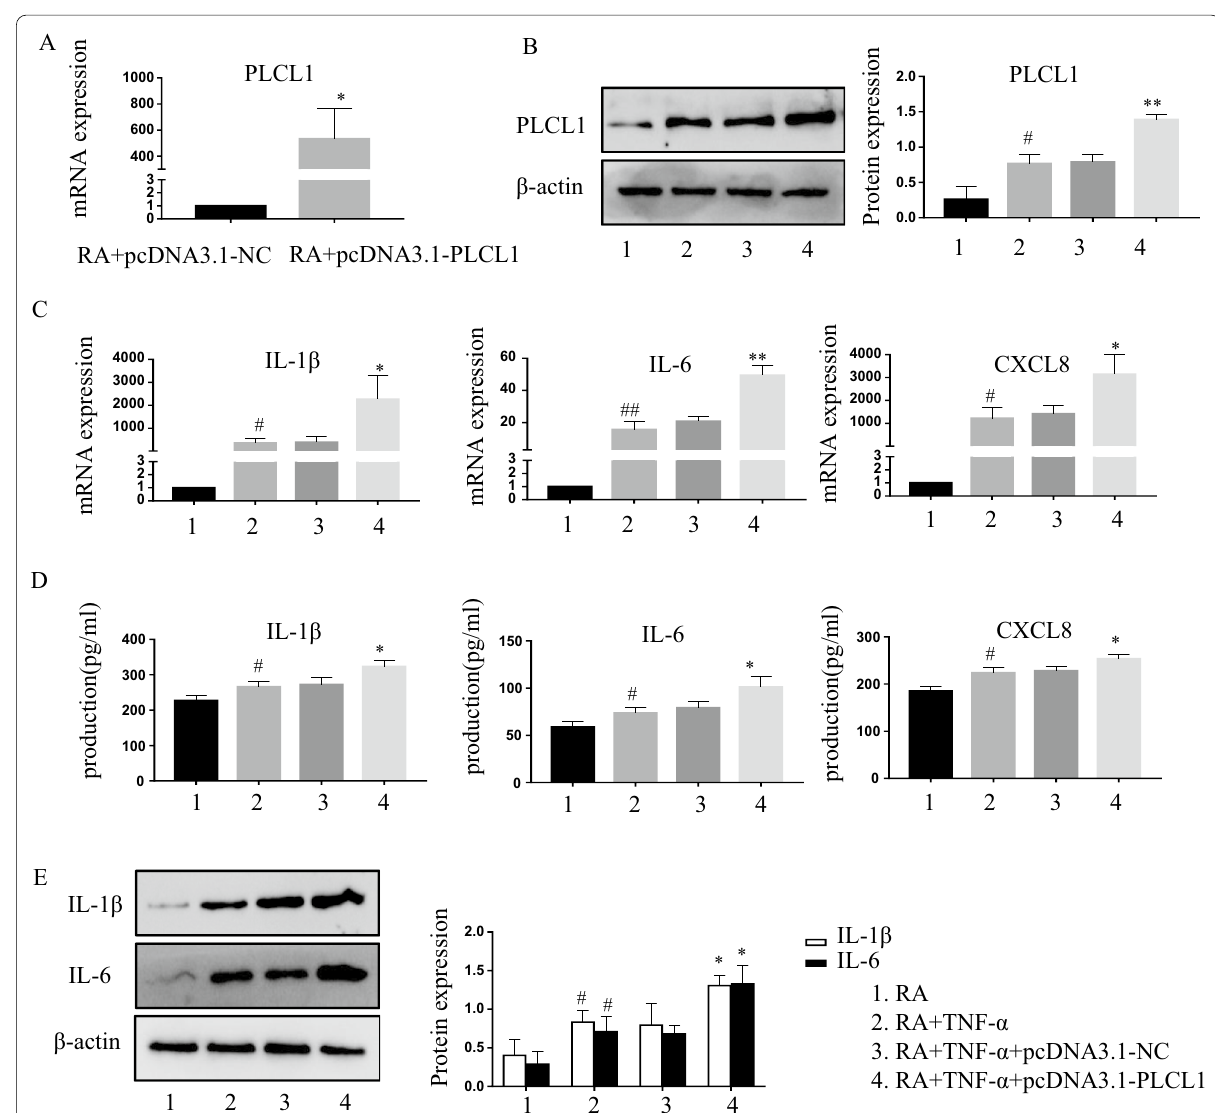
Fig. 4 Effect of PLCL1 overexpression promoted FLS expressing inflammatory cytokines. a The overexpression efficiency of PLCL1 were analyzed by RT‑QPCR in RA FLS. b The protein levels of PLCL1 were analyzed by WB in TNF‑α‑incubated in RA FLS after using PLCL1 overexpression plasmids. c The mRNA levels of IL‑6, CXCL8 and IL‑1β were analyzed by RT‑QPCR in TNF‑α‑incubated in RA FLS after using PLCL1 overexpression plasmids. d ELISA was used to detect the production of IL‑6, CXCL8 and IL‑1β in TNF‑α‑incubated RA FLS supernatants after using PLCL1 overexpression plasmids. e The protein levels of IL‑6 and IL‑1β were analyzed by WB in 10 ng/ml TNF‑α‑incubated in RA FLS after using PLCL1 overexpression plasmids. (Compared with the RA group # P < 0.05, ## P < 0.01; compared with the negative control group * P < 0.05, ** P <